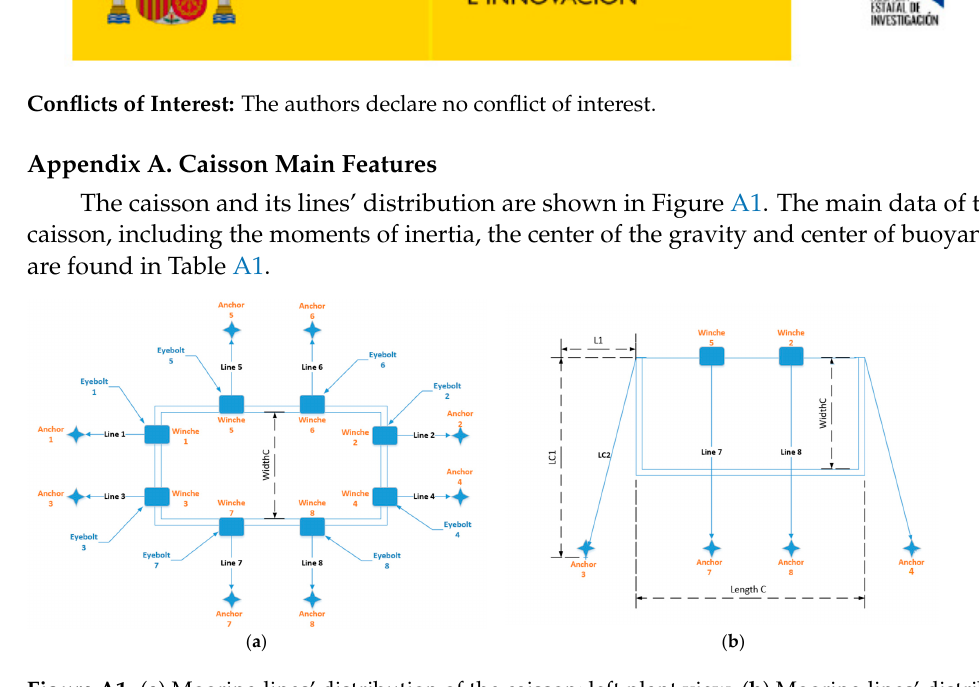
Figure A1. ( a ) Mooring lines’ distribution of the caisson; left plant view. ( b ) Mooring lines’ distribu- tion of the caisson; right lateral